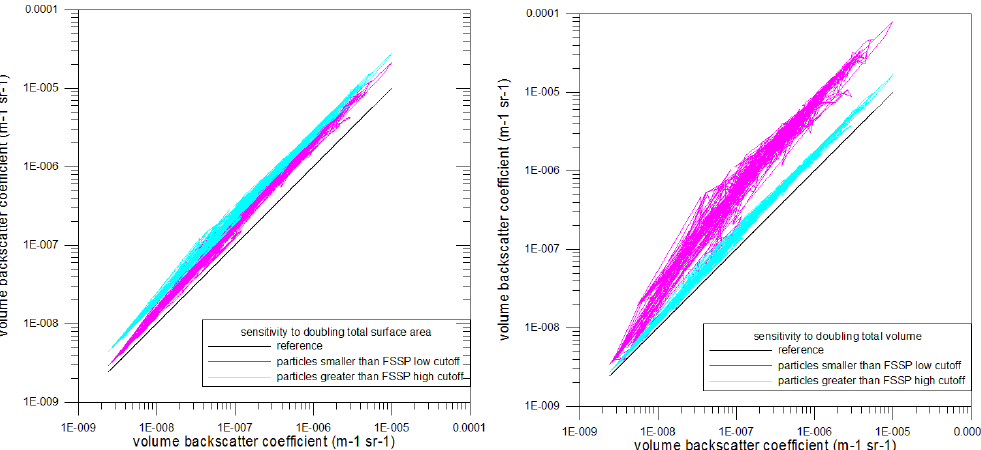
Fig. 3. Result of a sensitivity test, displaying a scatterplot of the Aerosol Backscatter Coefficient β values computed from a set of exper- imentally determined size distributions, with particles artificially added, whose radius was below (purple line) and above (blue line) the FSSP detection limit, plotted agains β from the unperturbed size distribution. The amount of additional particles was chosen to double the experimentally determined total surface area (left panel) or the total volume (right panel).